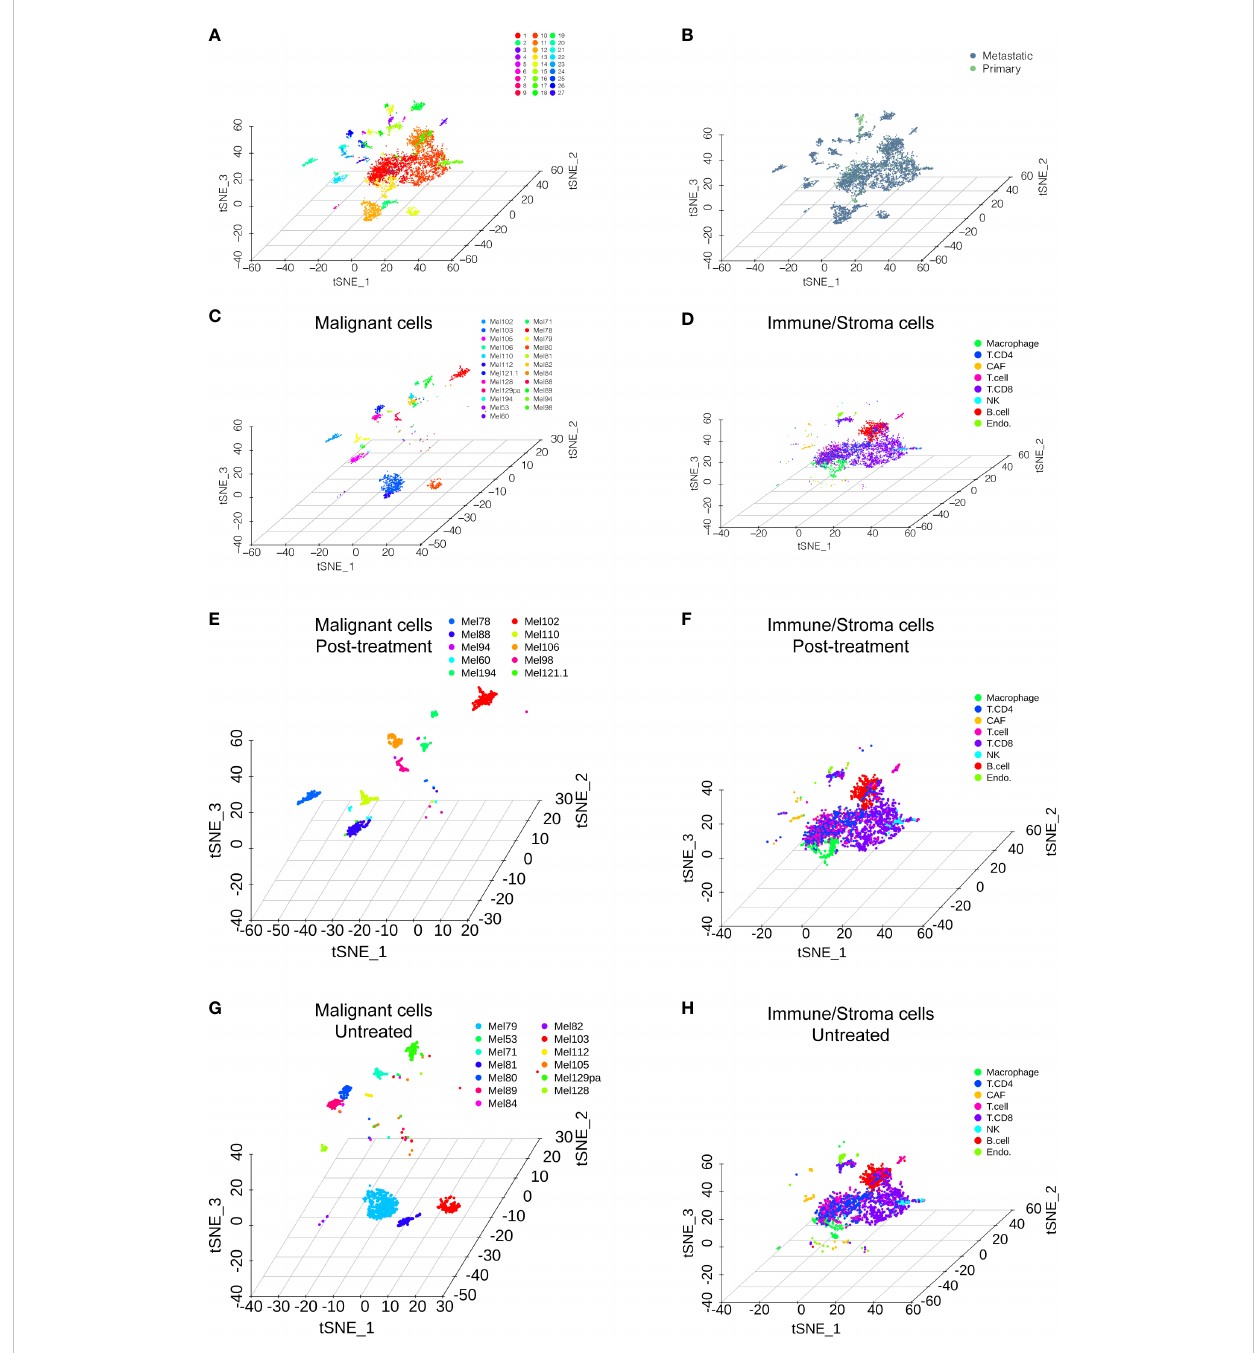
FIGURE 1 Single-cell RNA sequencing analysis of the GSE115978 dataset. (A) T-SNE of all of the melanoma samples with 27 clusters. (B) T-SNE of the metastatic melanoma and primary melanoma groups. (C) Malignant cells are categorized by the patients. (D) Nonmalignant cells, including immune cells and stromal cells, are classi fi ed by their cell type. The distribution of malignant cells and nonmalignant cells in the posttreatment group (E, F) and untreated group (G, H)